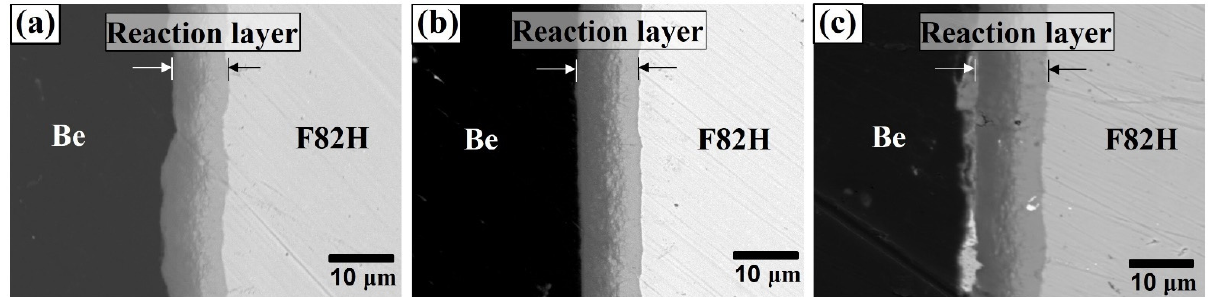
Figure 1. Cross-sectional SEM images of Be–F82H joints sintered at 1023 K for ( a ) 30 min, ( b ) 60 min, and ( c ) 90 min.